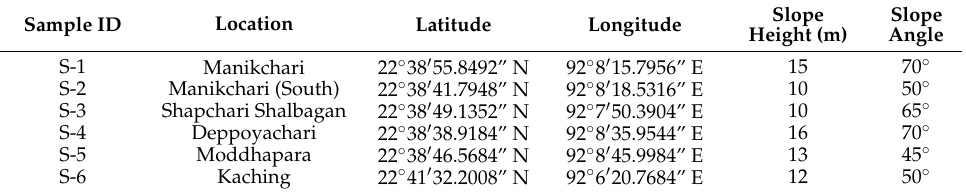
Table 1. Site locations and slope dimensions.